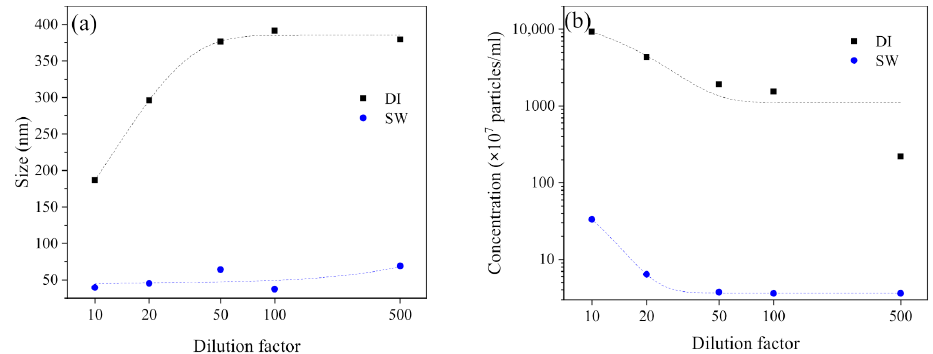
Figure 5. The effect of dilution on the size ( a ) and concentration ( b ) changes after exposing cit − AgNPs in DI and SW (pH = 8.7, IS = 100 mM) for 220